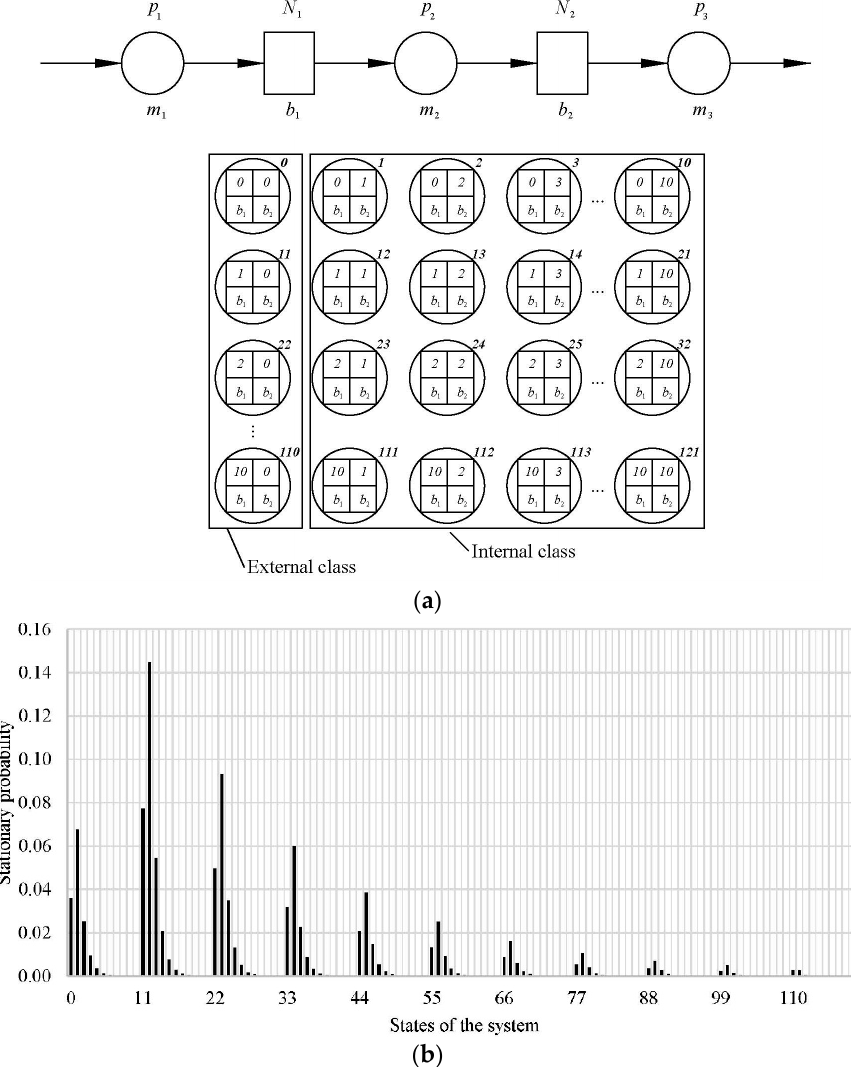
Figure 2. ( a ) The considered Bernoulli serial line ( p 1 = 0.6, p 2 = 0.7, p 3 = 0.8, N 1 = N 2 = 10) including the pertaining state space and ( b ) the distribution of the stationary probabilities across the state space (authors’ work).